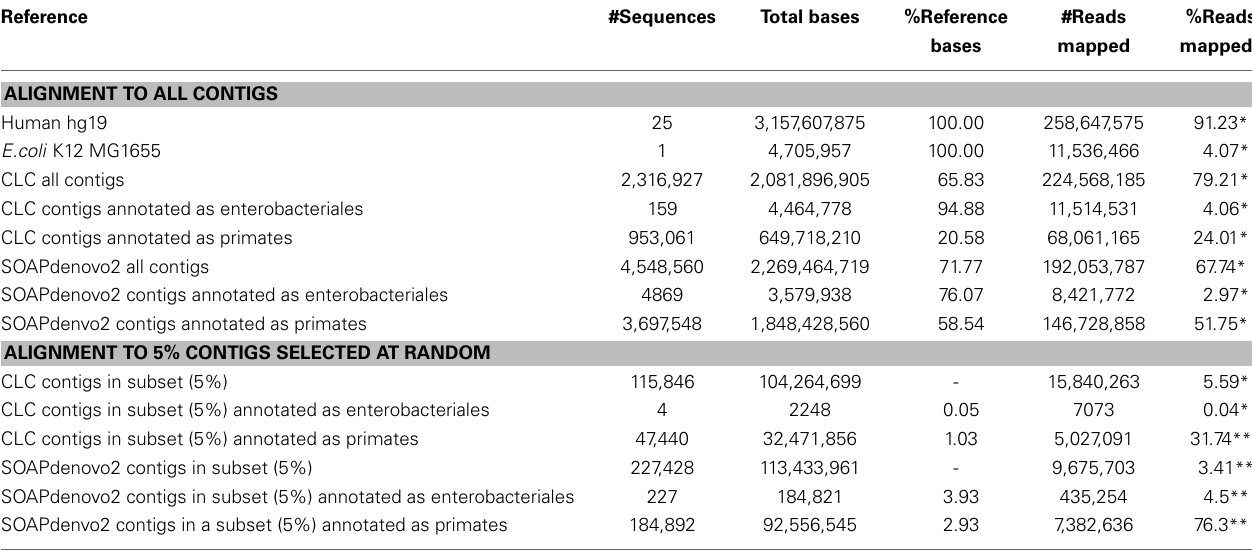
Table 5 | Mapping statistics for the mock-contaminated E. coli -human genomic